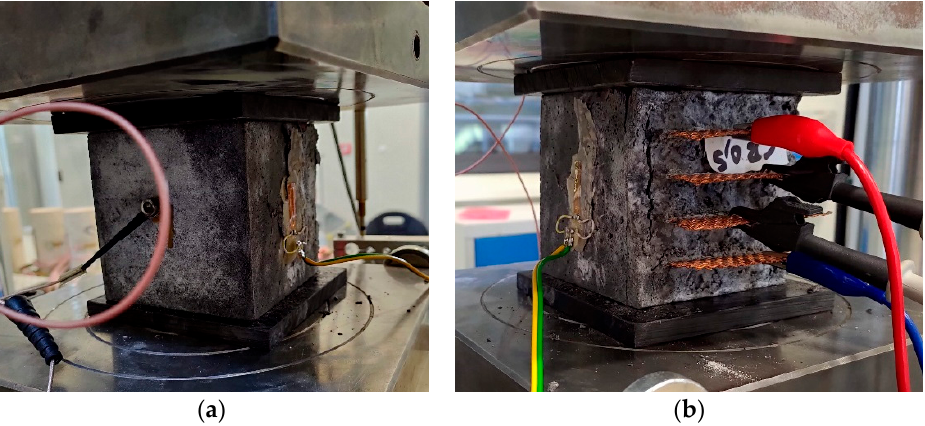
Figure 7. Delamination of the side wall of a specimen with an attached strain gauge. ( a ) back side; ( b ) front side.